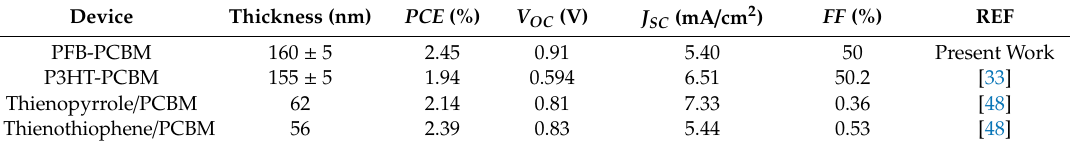
Table 2. Comparison of PCE, V OC , I SC , and FF of a PFB–PCBM-based device with the same device architecture poly(3-hexylthiophene) ((P3HT)–PCBM) at a nearly equal film thickness reported